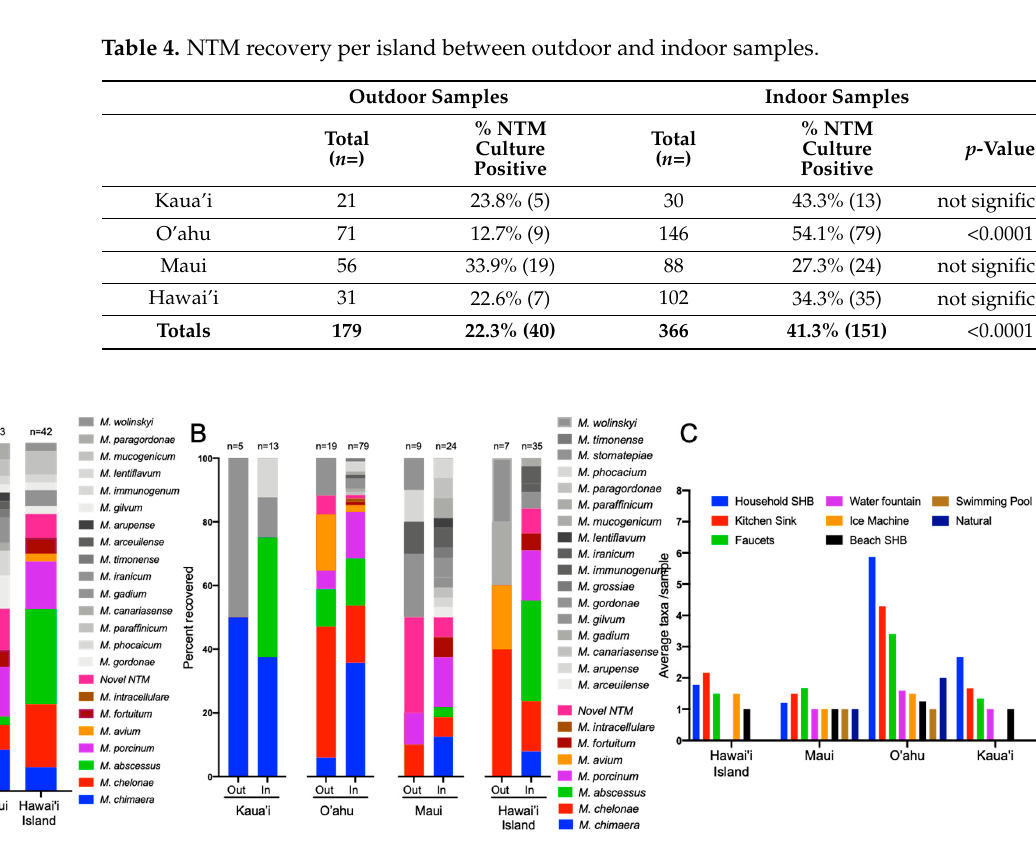
Figure 3. Clinically relevant NTM species predominate in Hawai’i environmental samples. ( A ) Colored bars correspond to the species of NTM identified using rpoB gene sequencing from all water biofilm samples stratified by island. Isolates shown in greyscale are generally not associated with pulmonary disease. The total number of NTM isolates recovered per sample type is shown above each column. ( B ) Data shown in “A” stratified by island and collection location (e.g., indoor or outdoor). The total number of NTM isolates recovered per sample type is shown above each column. ( C ) Average number of NTM species recovered per sample type per island as a measure to assess NTM diversity across different sample types. SHB = showerhead biofilm. Faucets include all bathroom and public restroom sink